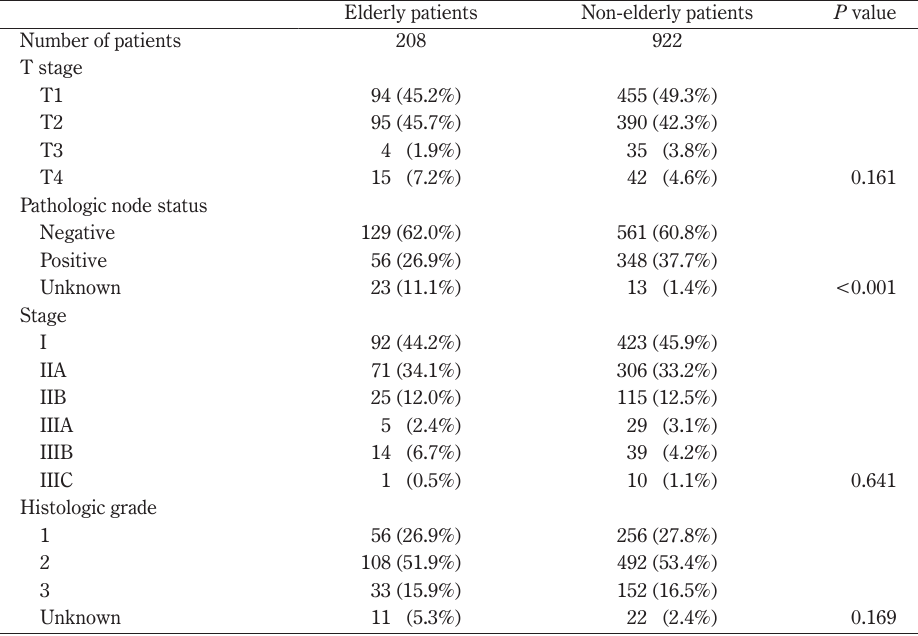
Table 1 Tumor pathological